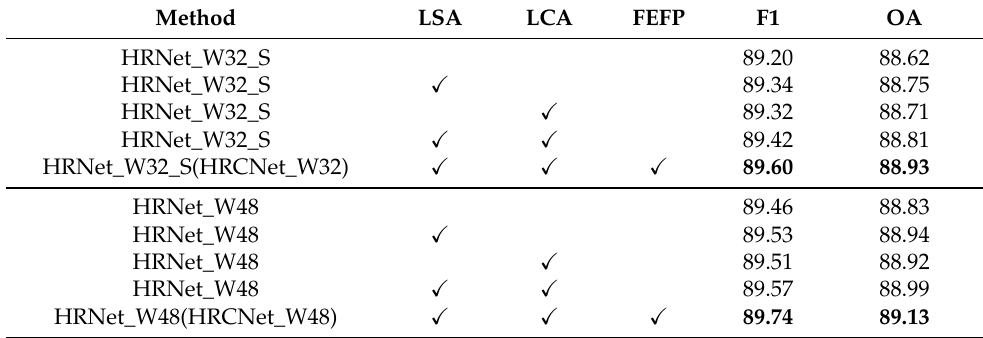
Table 10. The ablation experiments evaluated by F1 (%) and OA (%) about the proposed architectures. Method